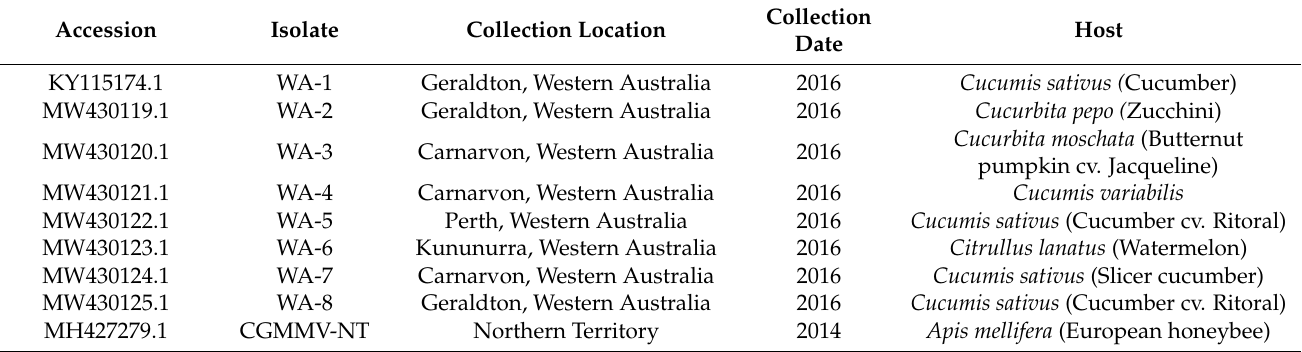
Table 3. Australian cucumber green mottle mosaic virus (CGMMV) genomes obtained from GenBank and used for comparison with new Australian